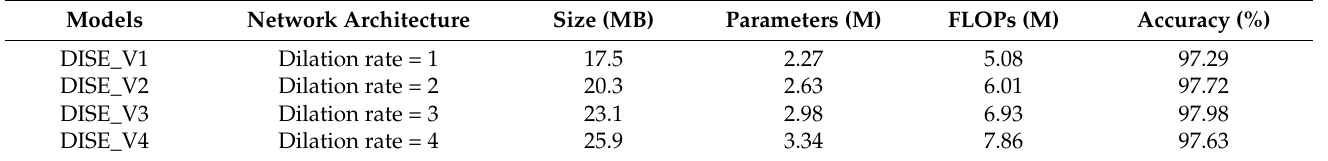
Table 7. The operation effect of network structure under different dilation rate